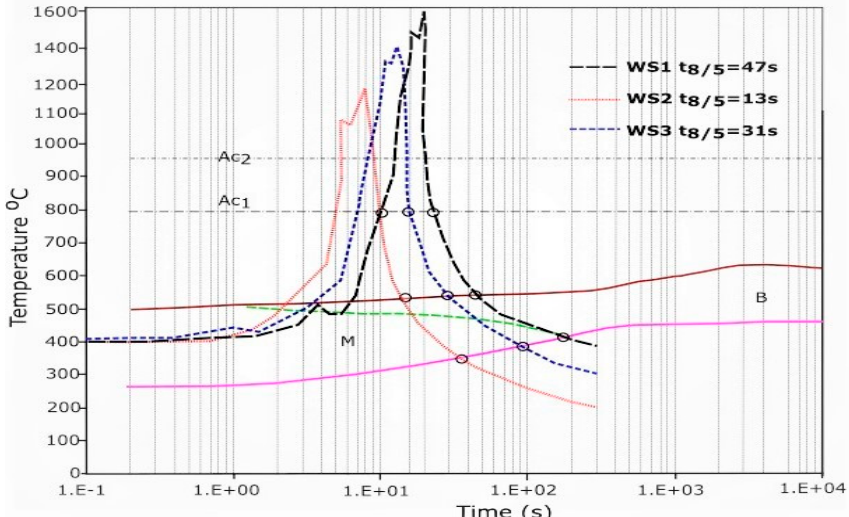
Figure 5. CCT diagram of S960QC steel (obtained using JMatPro software), including the cooling time curve values of the three heat input parameters.